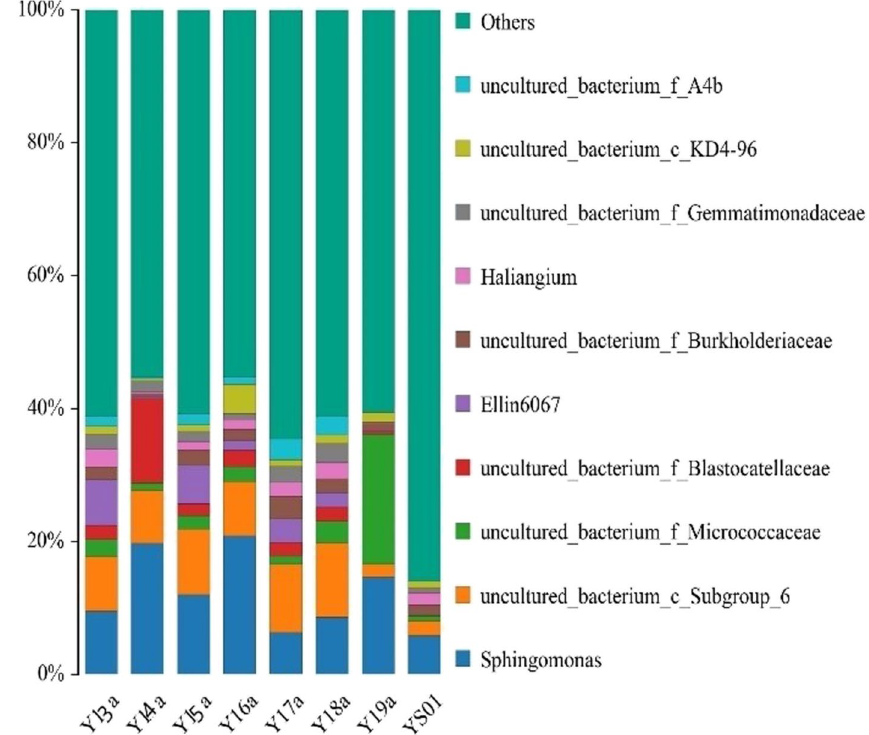
Fig. 4 Distribution of community structure of all samples at the genus